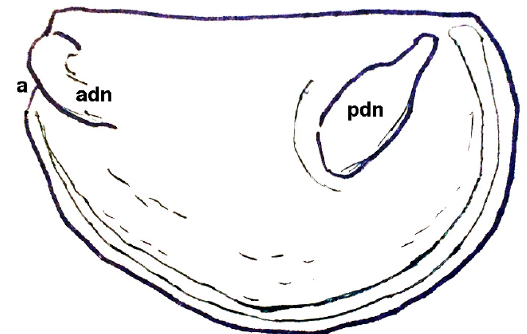
Figure 20. Kunmingella maotianshanensis . Anterior to left. Length of shield 4 mm. Abbreviations: a, anterodorsal cardinal marginal concavity; adn , anterodorsal node; pdn , posterodorsal node. Image Credit: Mark McMenamin.